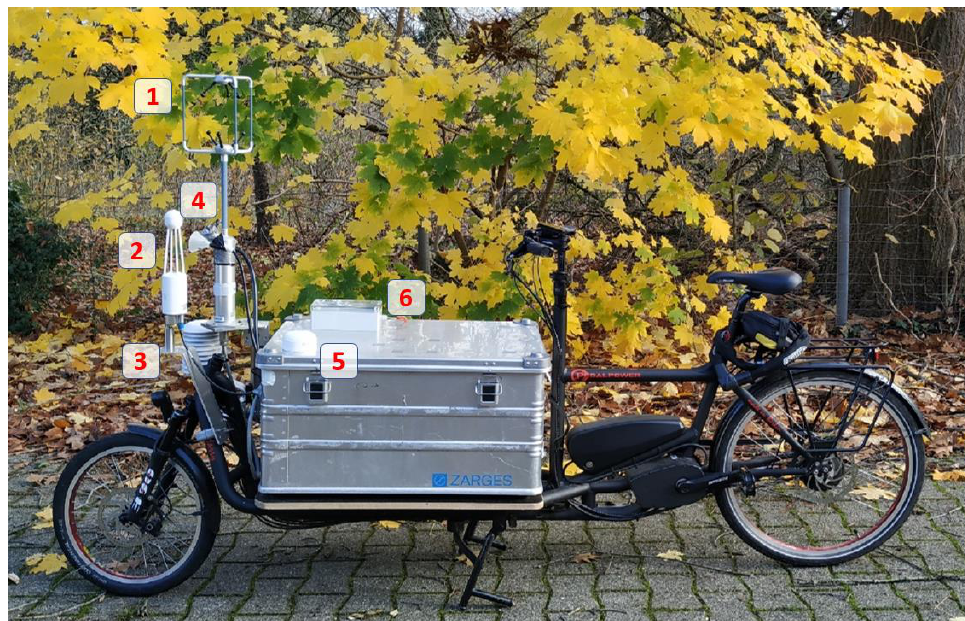
Figure 1. Instrumented cargo bicycle with electric motor assistance with ultrasonic anemometer (1); CO 2 and H 2 O analyzer (2); standard temperature and humidity probe in a radiation shield (3); aerosol particle inlet funnels (4); GPS receiver (5); and compass (6). Integrated in the metal box are the power supply, CPC, OPS particle sizer, and data acquisition equipment.